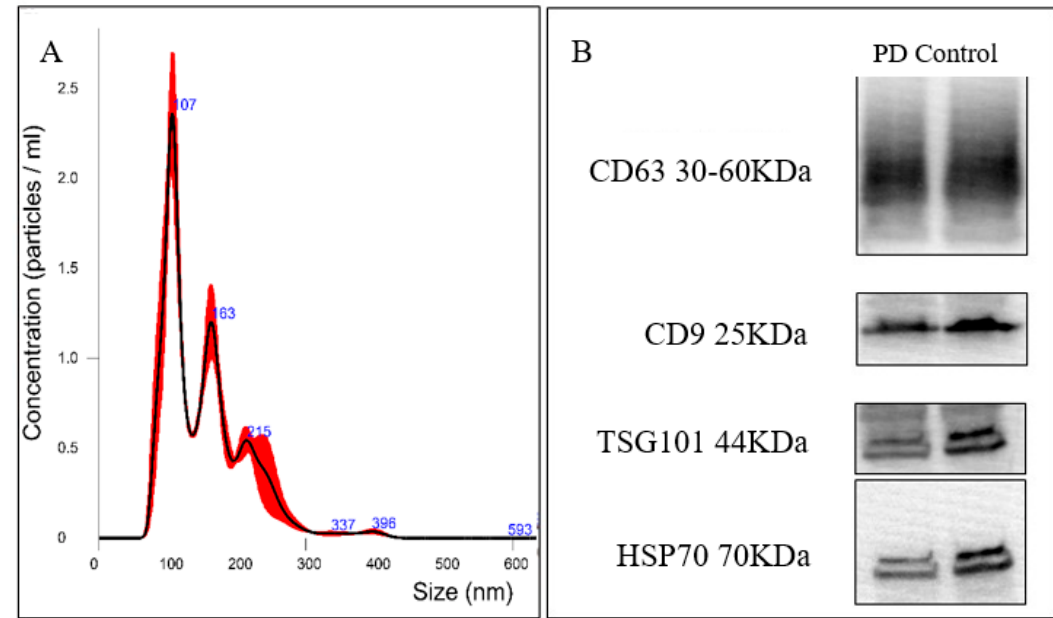
Figure 1. Characterization of isolated plasma exosomes. ( A ) Nanoparticle tracking analysis of the size distribution of isolated exosomes. ( B ) Representative Western blot images of the differential expression of exosomal markers CD63, CD9, and TSG101 in exosomes isolated from controls and Parkinson’s disease (PD) patients. HSP70 served as the loading control of exosomes.